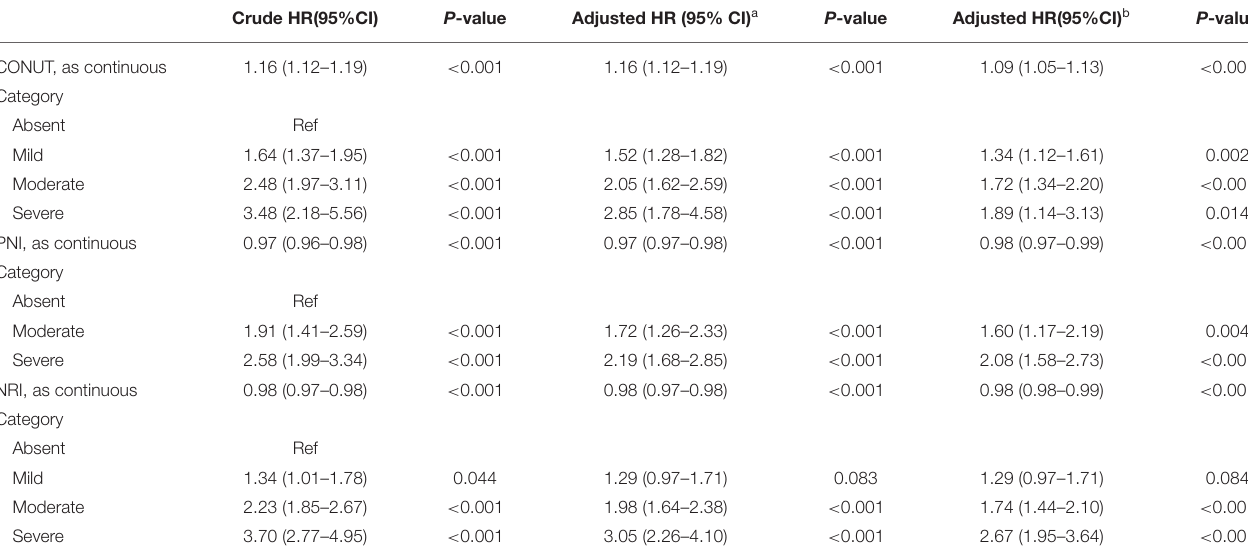
TABLE 2 | Cox proportional analyses of malnutrition indexes to predict all-cause mortality for elderly patients with